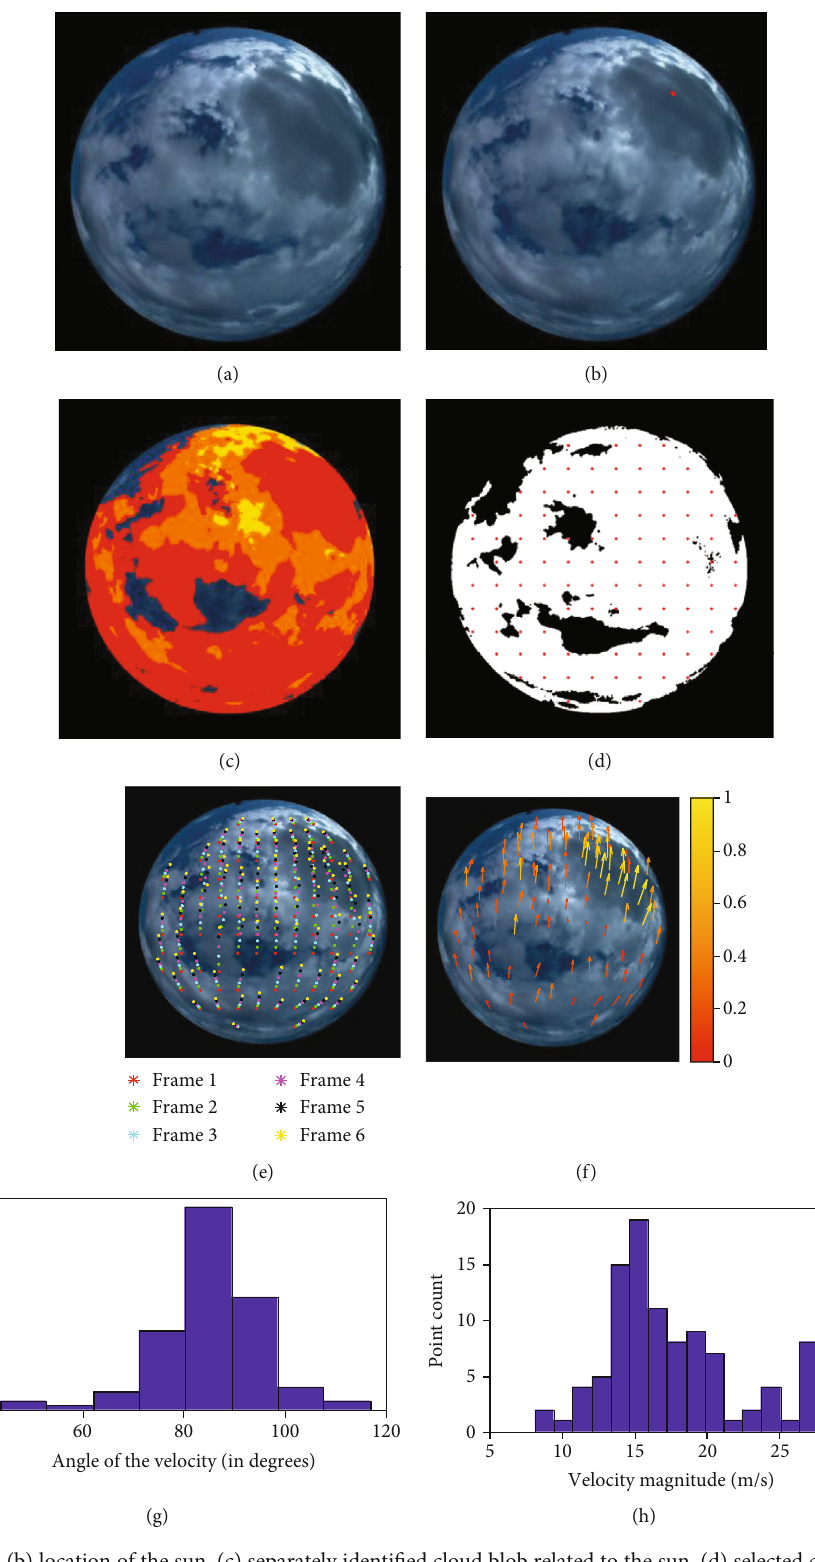
Figure 14: (a) Raw image, (b) location of the sun, (c) separately identi fi ed cloud blob related to the sun, (d) selected cloud points inside the selected cloud blob, (e) tracked cloud points over a 1-minute time interval, (f) mean value of the motion vectors of the selected cloud points, (g) velocity angle histogram, and (h) velocity magnitude